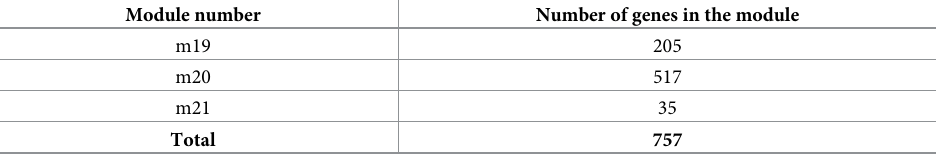
Table 2. Selected significant modules and the number of genes obtained on the